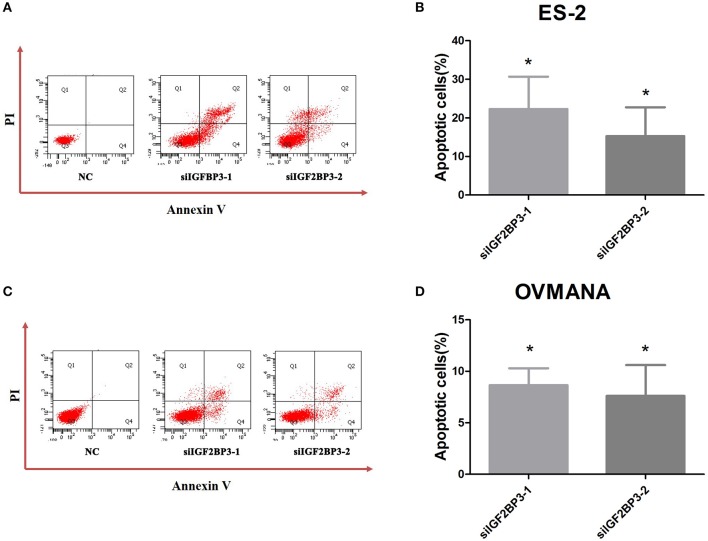
Effects of siIGF2BP3 on OCCC cell apoptosis. (A,C) Flow cytometry analysis after transfection with NC, siIGF2BP3-1, or siIGF2BP3-2 in both ES2 and OVMANA cell lines. (B,D) Quantitative analysis of apoptotic cells (%). Results were obtained from three independent experiments. NC group has been normalized as 0. *P < 0.05, compared with NC.